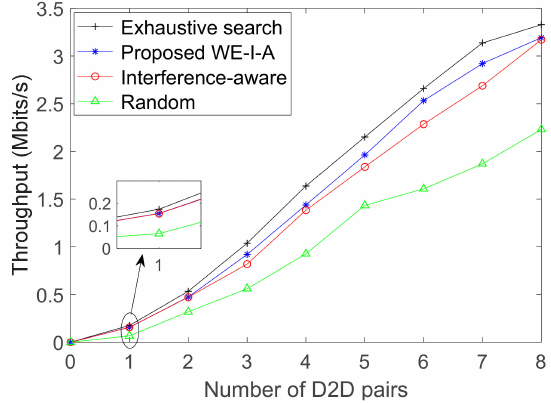
Figure 8. System throughput for di ff erent allocation algorithms in case of α =